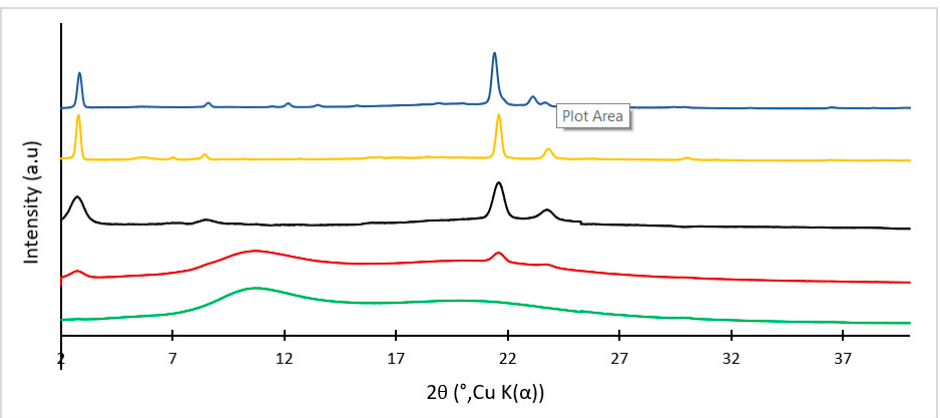
Figure 5. Powder X-ray diffraction patterns: a solidified melt of DIBA (blue), neat unmelted DIBA (yellow), empirically subtracted diffraction patterns of silicone oil from a 7 wt% DIBA in silicone oil (black) and from a 7 wt% DIBA in silicone oil gel (red), and from silicone oil (green). The Y-axes are offset vertically.